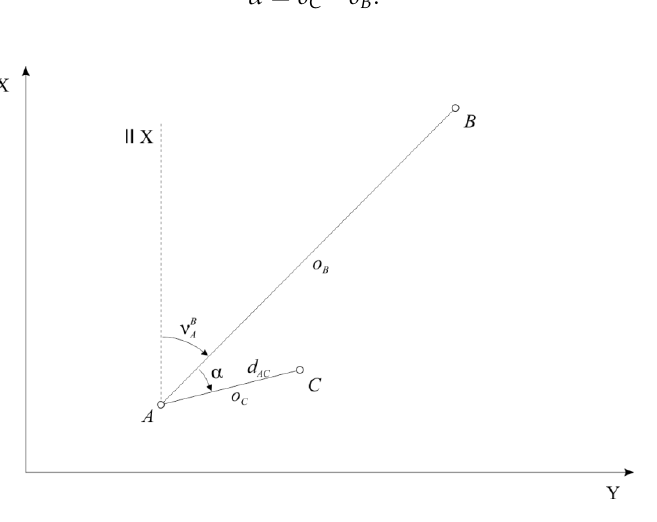
Figure 3. Polar measurement method.